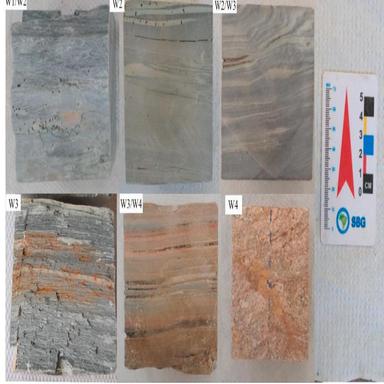
Different degrees of phyllite weathering. Samples W1/W2, W2, W2/W3, W3, and W3/W4 were collected from the profile Phy02 while the sample W4 was extracted from the profile Phy03. Veins composed of opaque minerals and chlorite exhibit a green color in the phyllites W2 and W2/W3, the latter showing the onset of weathering in this feature. In W3/W4, these veins lose their green color due to the transformation of chlorite into clay and present a dark color resulting from the alteration of opaque minerals. This f